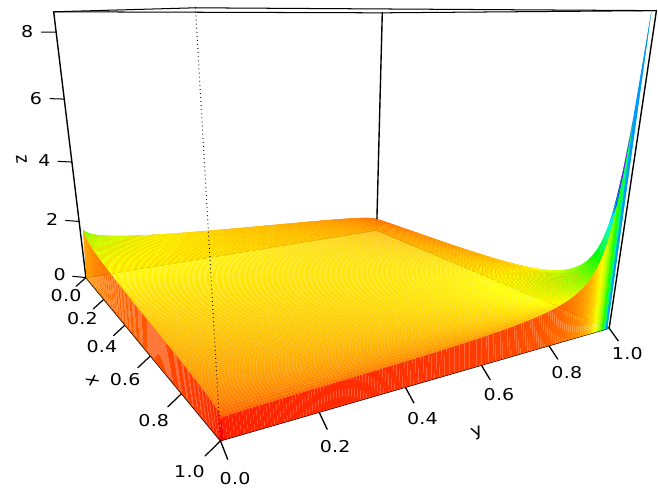
Figure 12. Density function of the estimated Gumbel Copula. Attritional claim losses on the X-axis, large claim losses on the